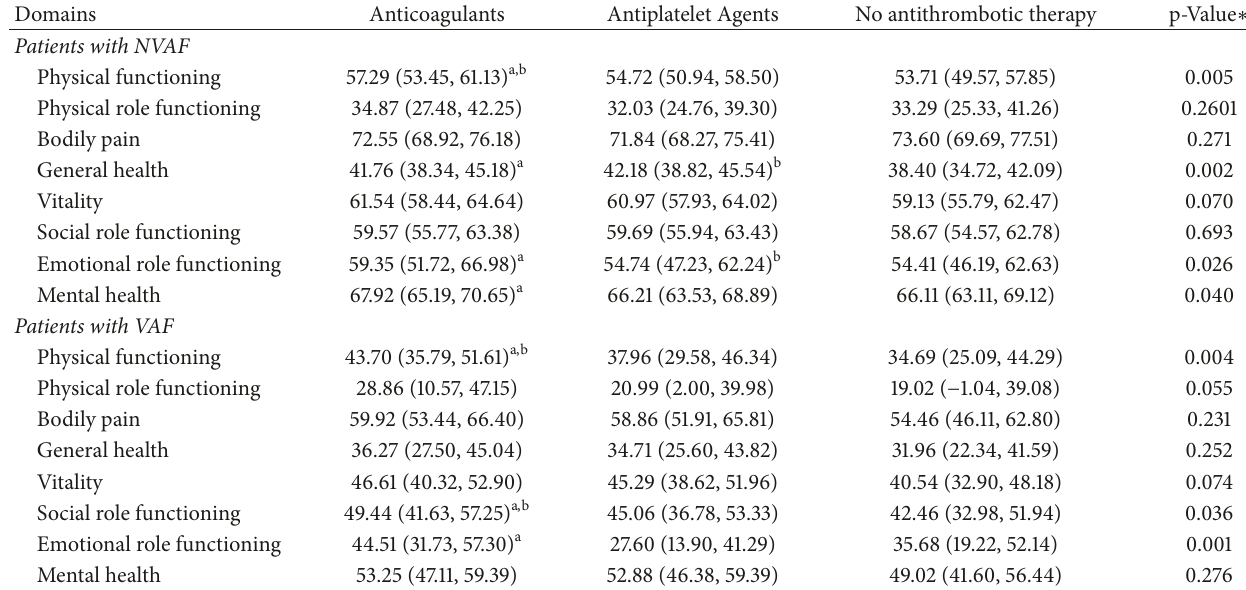
Table 3: The impact of anticoagulant and antiplatelet treatment on QoL assessed by the SF-36 questionnaire in patients with NVAF and VAF (mean scores and 95%